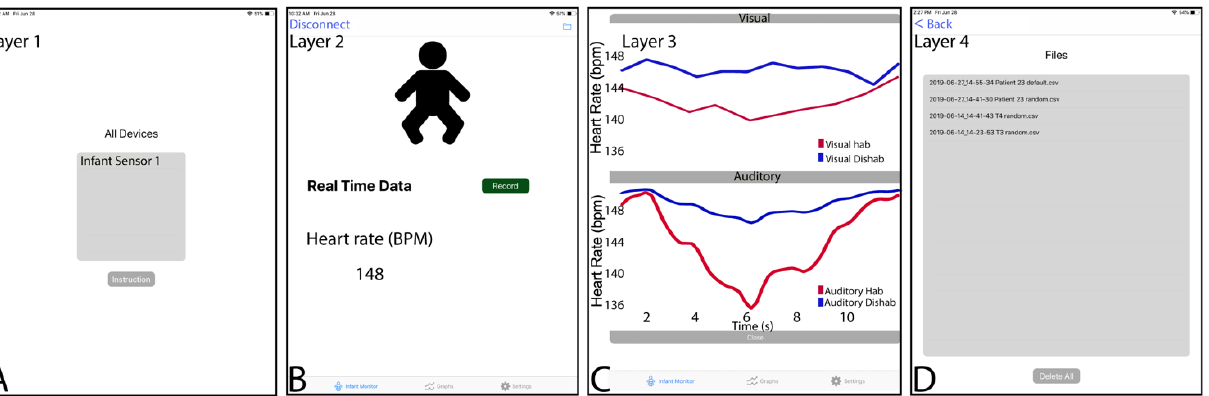
Figure 2. COR sensor. ( A ) Top view of the board showing the ECG components and BLE set chip for wireless communication. The bottom view shows the battery holder for a CR2030 coin cell. ( B ) The end-to-end length includes ground (black), main lead (blue), and the 3D-printed black plastic encase that protects the primary circuit. ( C ) An example of leads positioning on a 4-year-old child.